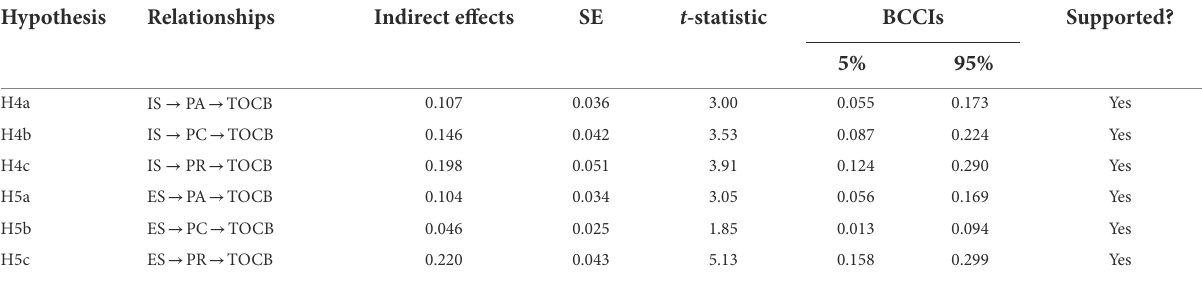
TABLE 6 Results of mediating